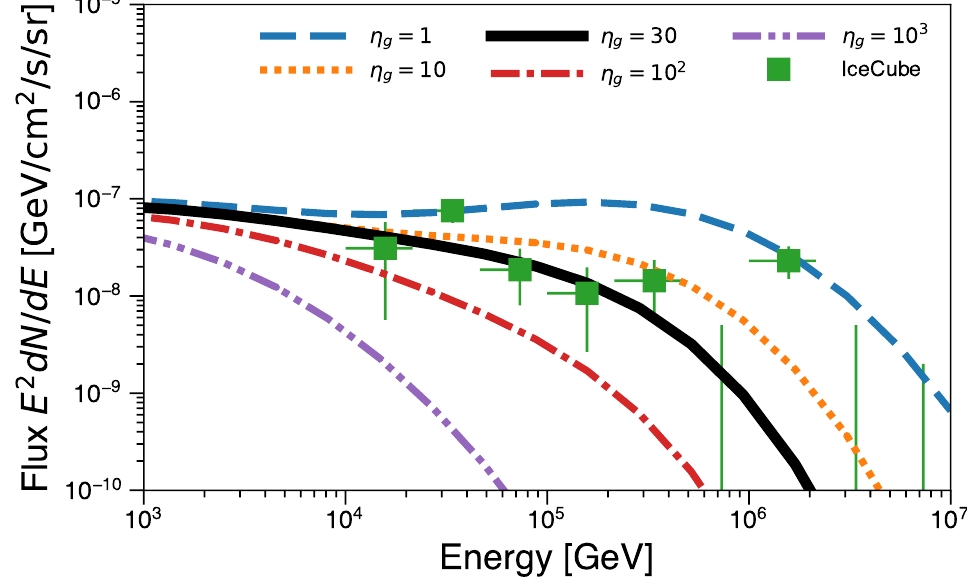
Figure 13. The cosmic neutrino background spectra per flavor from AGN coronae. The dashed, dotted, solid, dot-dashed, and double-dot-dashed curves show the contributions with η g = 1 (Bohm limit), 10, 30, 10 2 , and 10 3 , respectively. The square data points correspond to the cosmic neutrino background spectrum by IceCube [145]. Taken from Inoue et al.